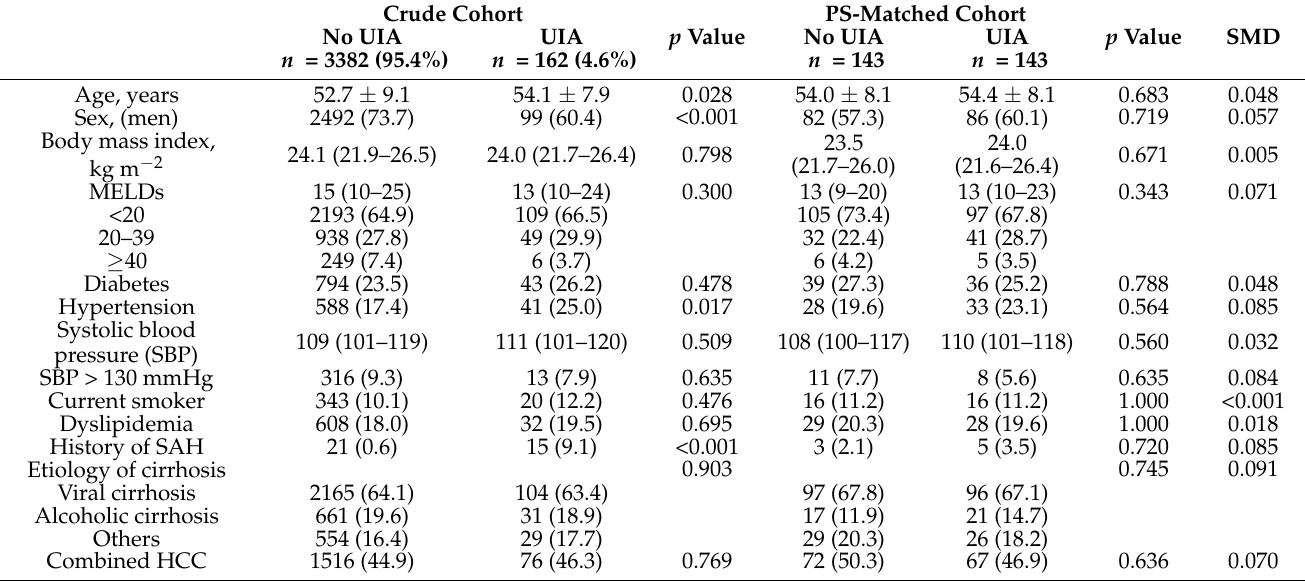
Values are expressed as the mean ( ± SD) or median (interquartile range) for continuous variables, and n (%) for categorical variables. HCC, hepatocellular carcinoma; MELDs, model for end–stage liver disease score; SAH, subarachnoid hemorrhage; UIA, unruptured intracranial aneurysm; SMD, standardized mean